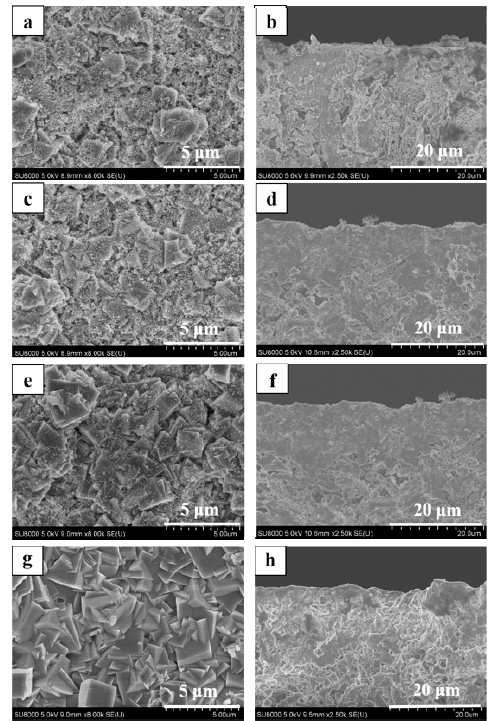
Figure 9. Surface and cross-sectional SEM images of high silica SSZ-13 zeolite membrane with different synthesis time, ( a , b ) M-9, 24 h; ( c , d ) M-10, 36 h; ( e , f ) M-4, 48 h; ( g , h ) M-11, 72 h.